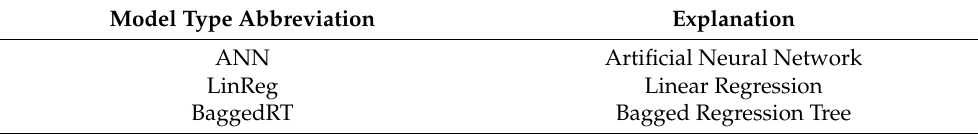
Table 2. Overview of model types used in supervised machine learning for prediction of the